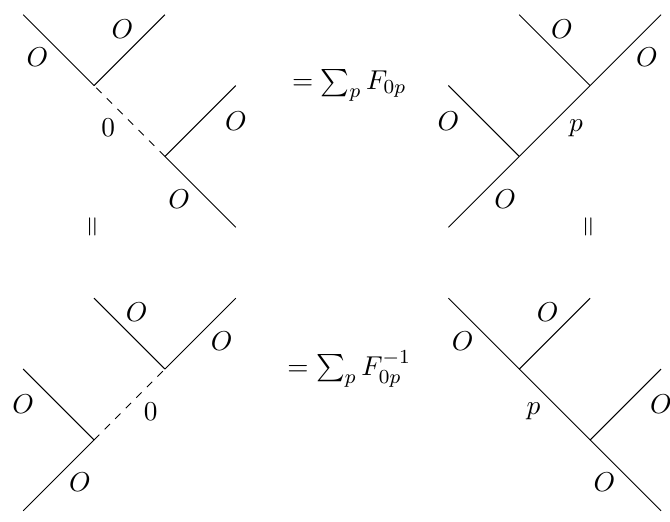
Figure 4 . One identi(cid:12)es F 0 p with F (cid:0) 1